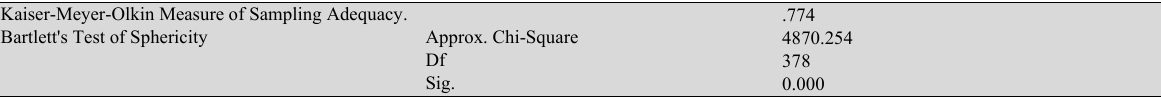
KMO and Bartlett’s test Kaiser-Meyer-Olkin Measure of Sampling Adequacy.